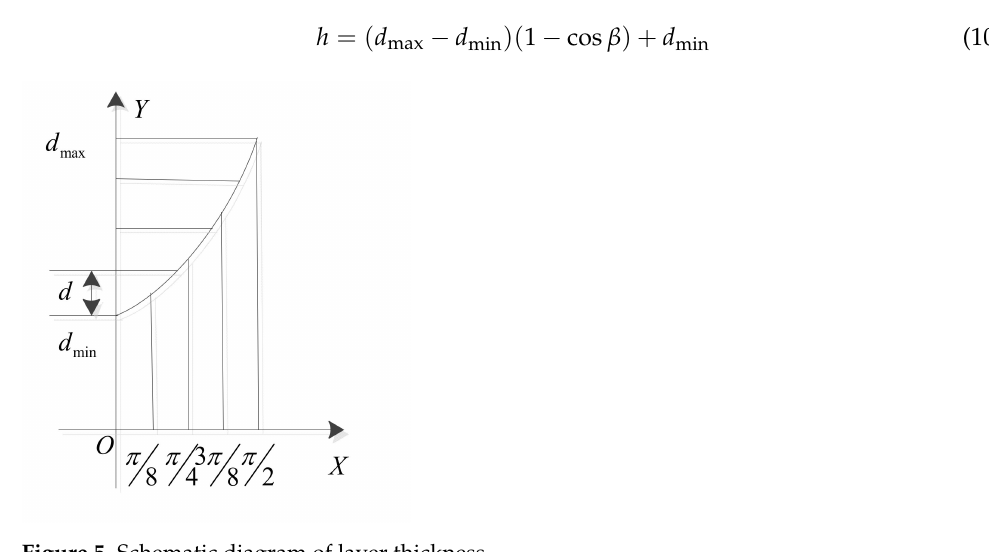
Figure 5. Schematic diagram of layer